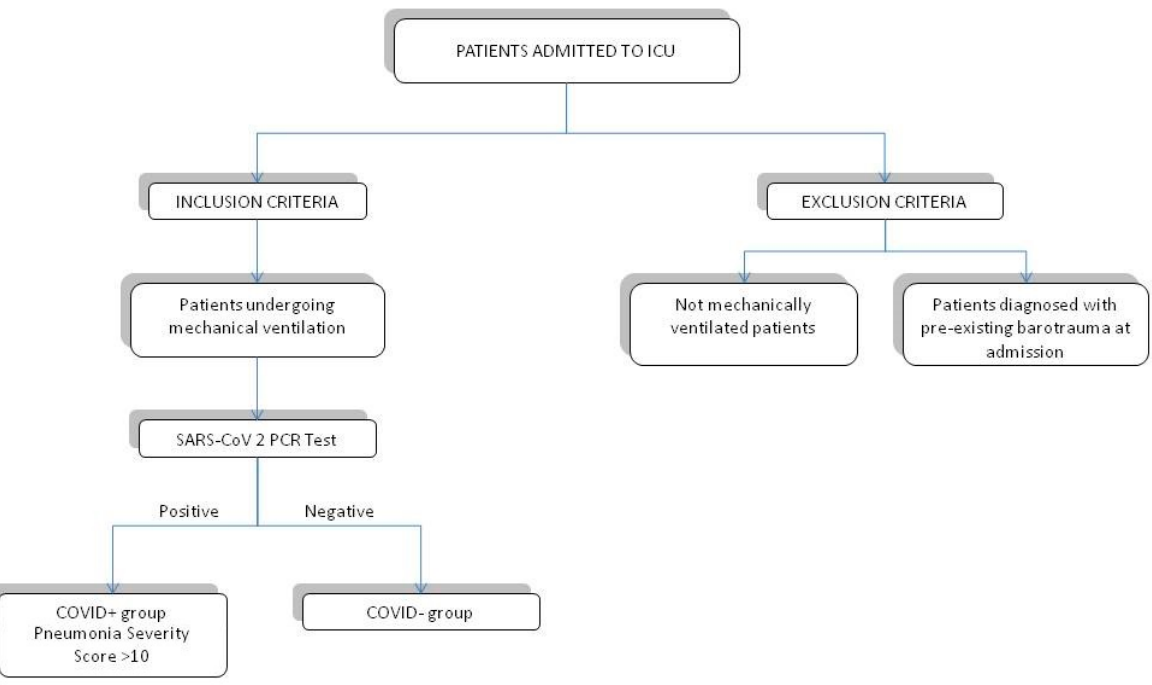
Figure 2. Flowchart: inclusion and exclusion criteria.